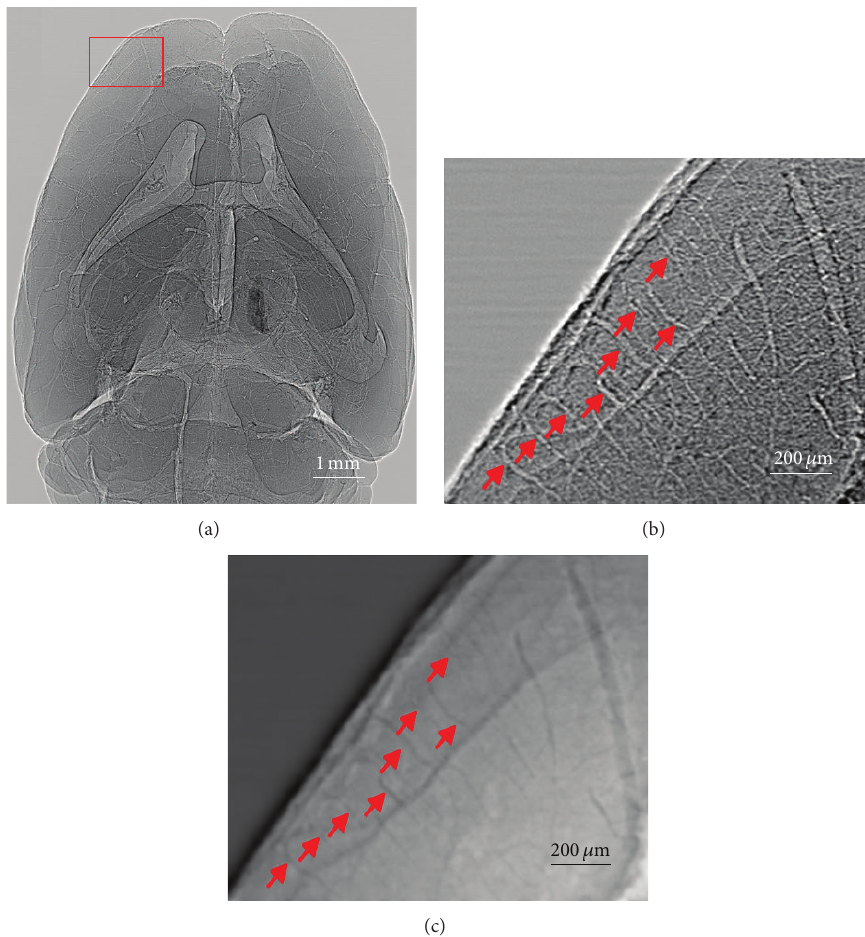
Figure 3: The corrected phase image of entire mouse brain sample (in air) based on the proposed method. Both cerebral arteries and veins were revealed in (a). The brain structures can also be identified including cerebral cortex, the lateral ventricle (LV), and the third ventricle of cerebrum thalamus and cerebellum (CB). (b) Enlarged image of red box area in (a). (c) The phase retrieved image of